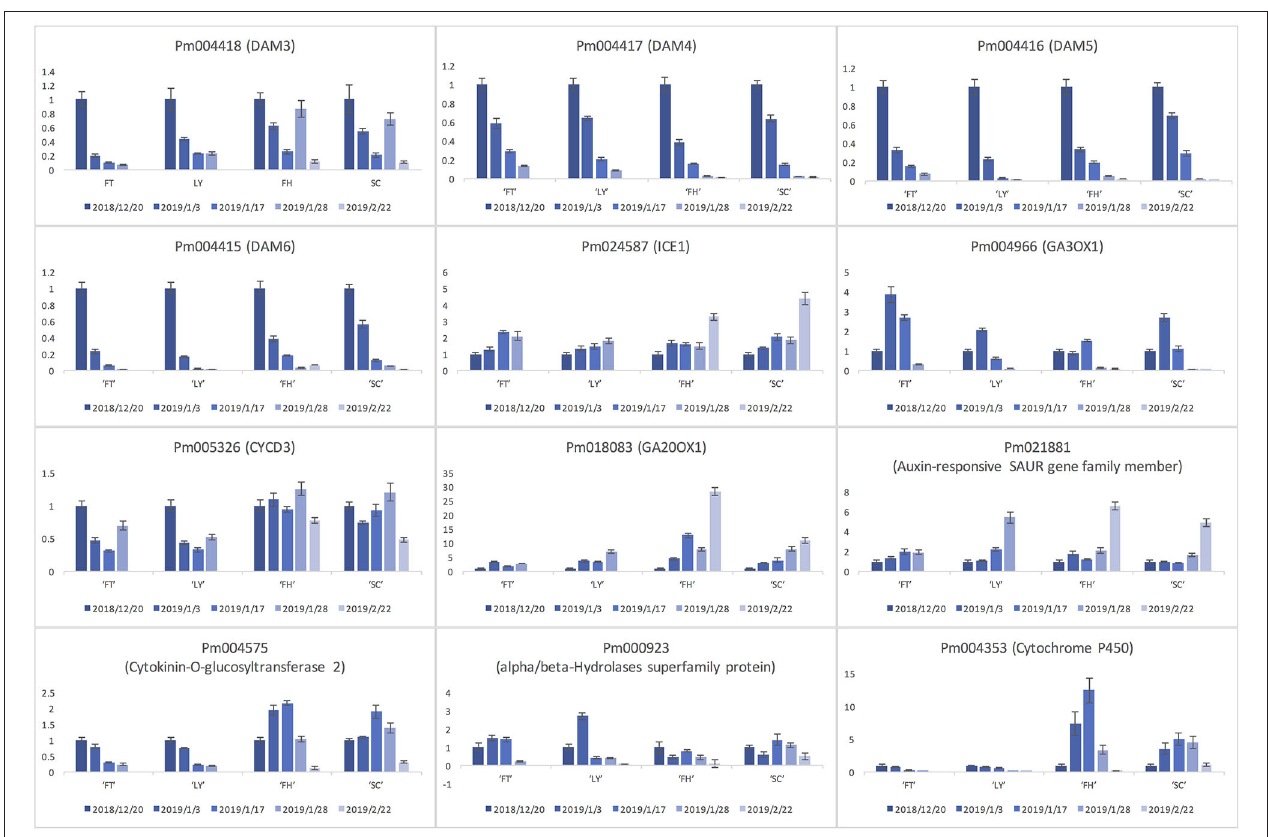
FIGURE 7 | The expression profiles of selected gene candidates during flowering process in four P. mume cultivars including “Fentaichuizhi” (“FT”), “Longyou” (“LY”), “Fenghou” (“FH”), and “Songchun” (“SC”).